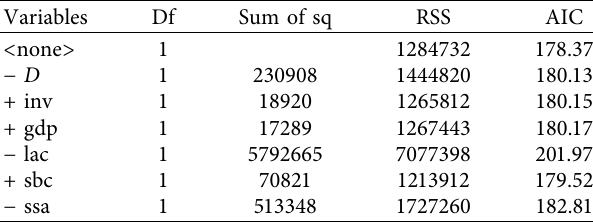
Table 3: Results of stepwise regression